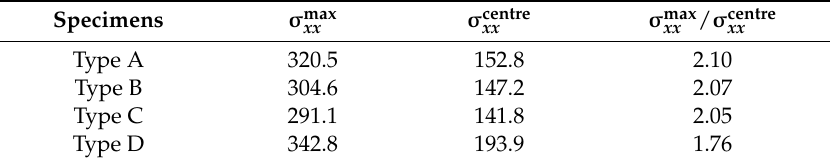
Table 1. σ max xx / σ centre xx